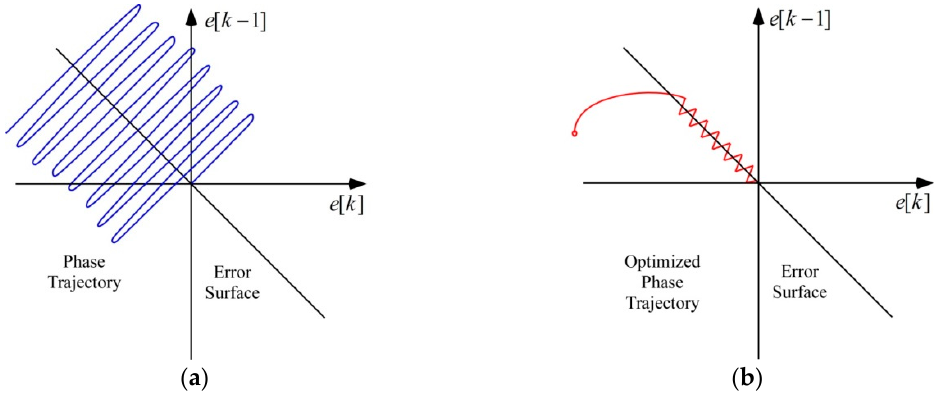
Figure 5. Error surface illustration for: ( a ) the conventional LMS method; and ( b ) SM-LMS.